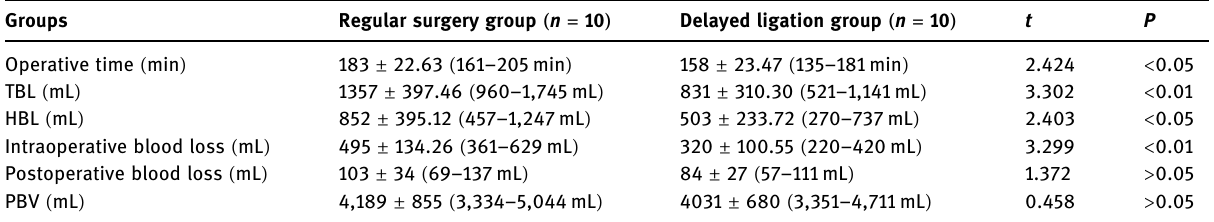
Table 2: The operative time and blood loss of patients who underwent regular surgery or delayed ligation hip disarticulation